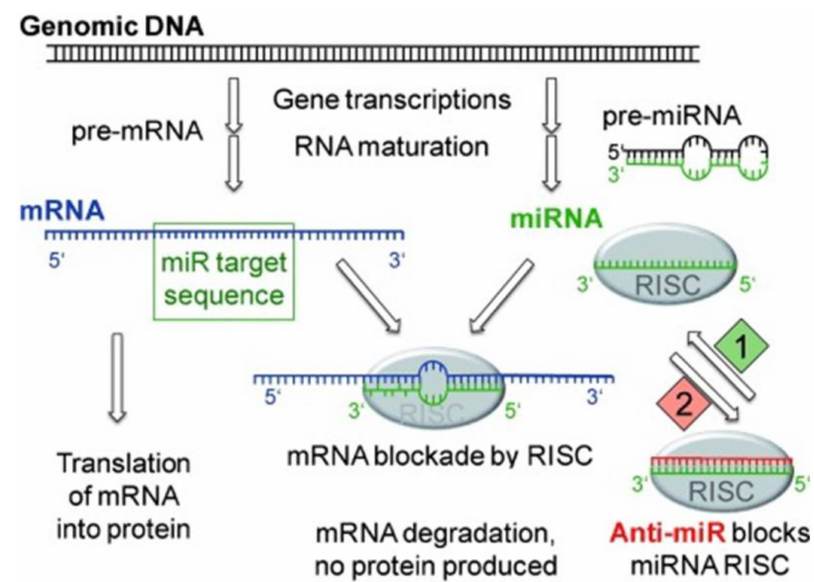
Figure 2. Mechanism of RNA interference (RNAi) and options for therapeutic intervention. (1) Substitution of tumor suppressor micro-RNA (miRNA, miR) in form of pre-miRNA or miRNA mimics, thereby inducing RNAi. (2) Blocking of oncogenic miRNA by miRNA-specific antagomirs (anti-miR). This figure is reprinted with permission from [103]. Copyright © 2020; John Wiley and